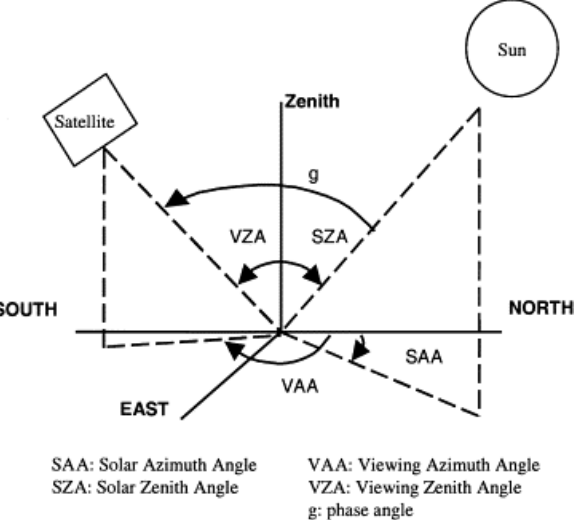
Figure 3. Solar illumination geometries and viewpoint geometries in spaceborne and airborne EO image acquisition.